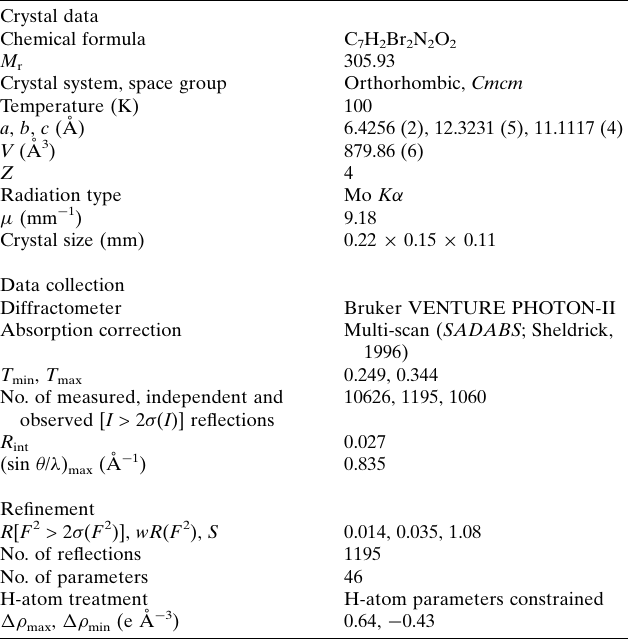
Table 2 Experimental details. Crystal data Chemical